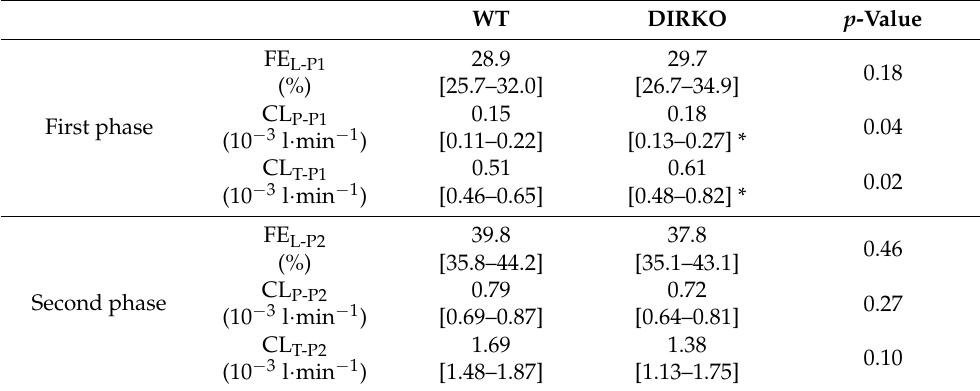
Table 1. Values for hepatic, extrahepatic, and total insulin clearance in the IVGTT first and second phases for DIRKO and WT mice.